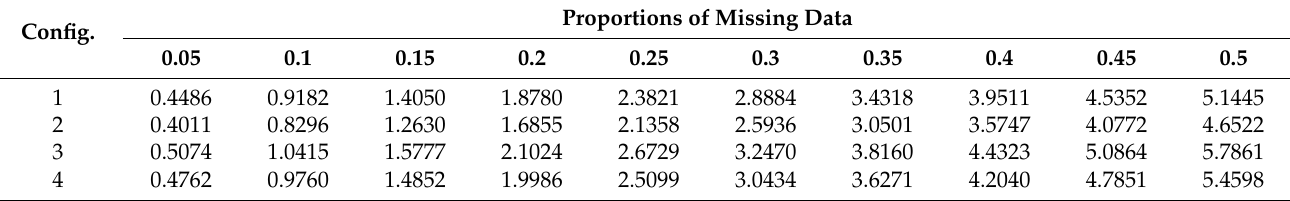
Proportions of Missing